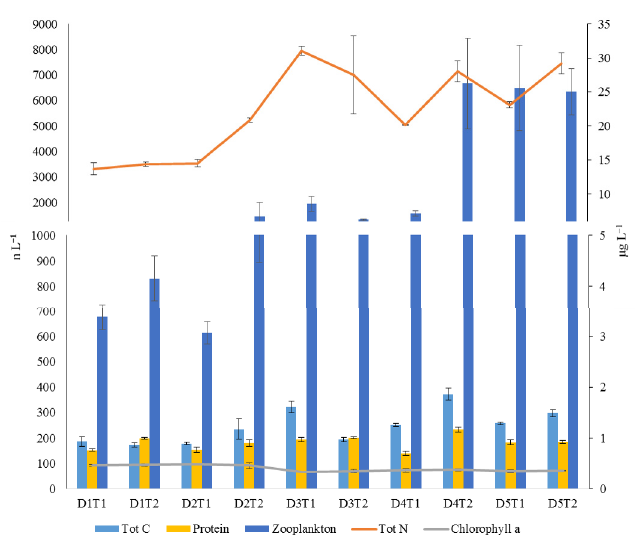
Figure 1. The seston (total carbon, protein, total nitrogen, and clorophyll a; right axis) and zooplankton variables (left axis) characterizing the several sampling times within the sampling days.